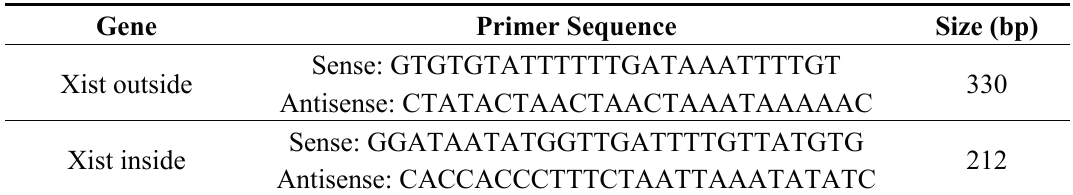
Table 4. Primer sequence for Bisulfate-Specific (BS)-PCR